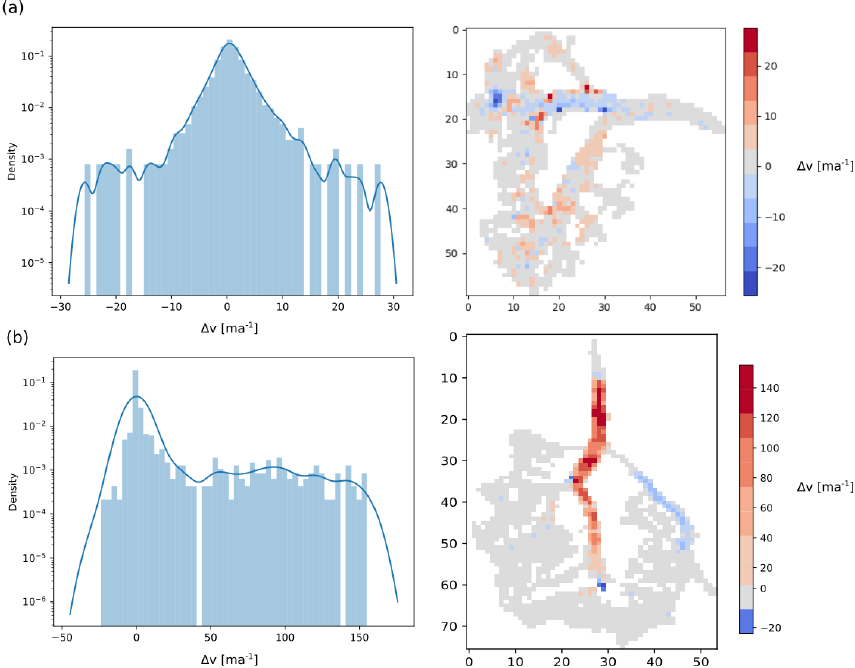
Figure 2. Distribution and map of d V for two glaciers. (a) Non-surge-type glacier: Samudra Tapu Glacier in 2013, Chandra River basin, Western Himalaya. Note the symmetrical d V distribution. (b) Surge-type glacier: K2 North Glacier complex in 2015, Karakoram. Note the positive heavy tail on d V as a consequence of surging